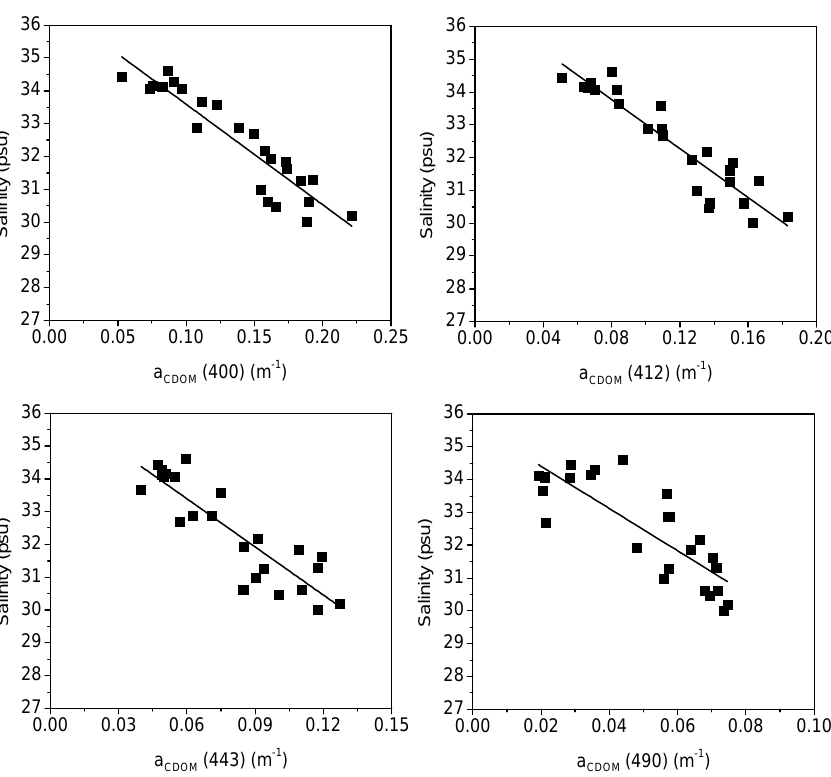
Fig. 4. Relationships between the salinity and a CDOM ( λ ) (m -1 ) observed in estuarine and offshore waters of the ECS during 2002–2005 ( N =24).